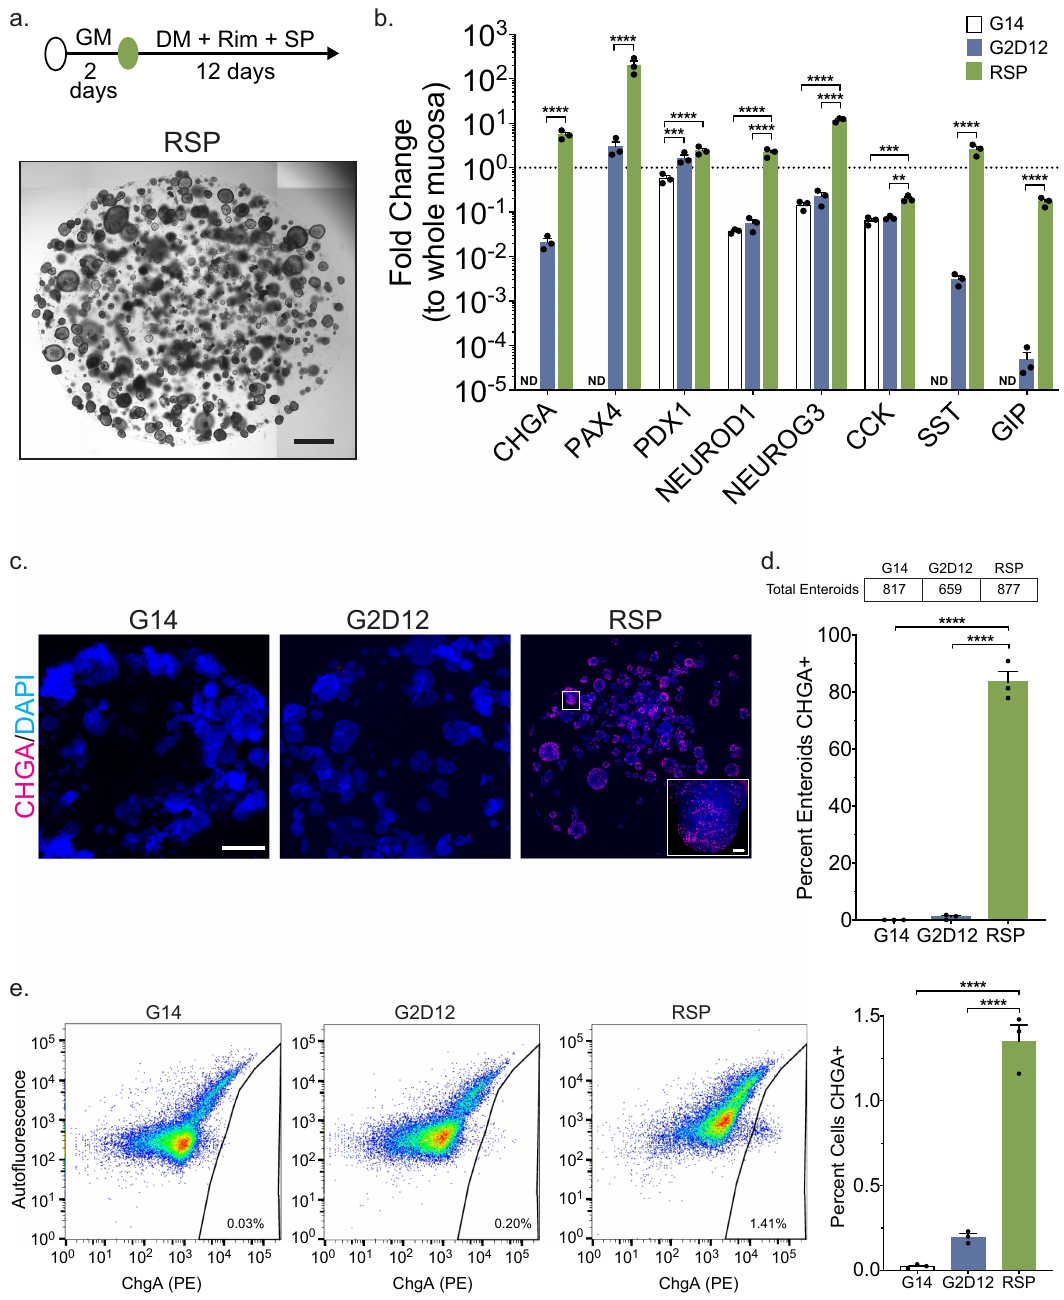
Fig. 2 Differentiation with small molecules rimonabant and SP600125 induces CHGA expression. a Representative light microscopy of enteroids (whole well) grown in growth media for 2 days followed by 12 days in differentiation media with rimonabant and SP600125 (RSP). Culture schematic located above panel. Scale bar = 1 mm. b qPCR analysis of enteroendocrine markers of enteroids grown in G14, G2D12 or RSP compared to duodenal whole mucosa and normalized to 18S. Dotted line denotes expression level in whole duodenal mucosa. Representative experiment showing n = 3 wells from each condition from a single enteroid line. CHGA = chromogranin A, PAX4 = paired box 4, PDX1 = pancreatic and duodenal homeobox 1, NEUROD1 = neuronal differentiation 1, NEUROG3 = neurogenin 3, CCK = cholecystokinin, SST = somatostatin, GIP = glucose-dependent insulinotropic peptide, ND = not detectable in one or more samples. ** p = 0.0025; *** p = 0.0009 ( PDX1 ), 0.0003 ( CCK ); **** p < 0.0001. c Representative immuno fl uorescence staining of CHGA (magenta) in enteroids (whole well) treated with G14, G2D12 and RSP. Boxed portion magni fi ed in lower right corner. Nuclei (4 ′ ,6-diamidino-2- phenylindole (DAPI), blue). Scale bars = 1 mm and 50 µ m (boxed portion). d Percentage of enteroids with positive CHGA staining in G14, G2D12 and RSP treatments. Table above graph shows the total number of enteroids examined per condition. Average results are from three separate experiments from three different enteroid lines or passages. **** p < 0.0001. e Left three panels: Representative fl ow cytometry plots of CHGA + cells from enteroids grown in G14, G2D12, or RSP. Right panel: Percentage of CHGA + cells per well. Representative experiment showing n = 3 wells from each condition from a single enteroid line. **** p < 0.0001. Bars show mean ± SEM; two-way ANOVA with Tukey correction for multiple comparisons ( b ); one-way ANOVA with Tukey correction for multiple comparisons ( d , e ). Each experiment repeated with at least three different enteroid lines. Speci fi c conditions were excluded from statistical analysis if the data from one or more samples was labeled as not detectable. Source data are provided as a Source Data fi le.